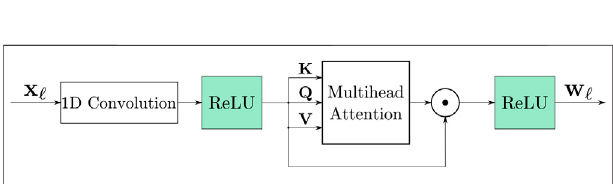
FIGURE 6 | Convolutional MHA encoder